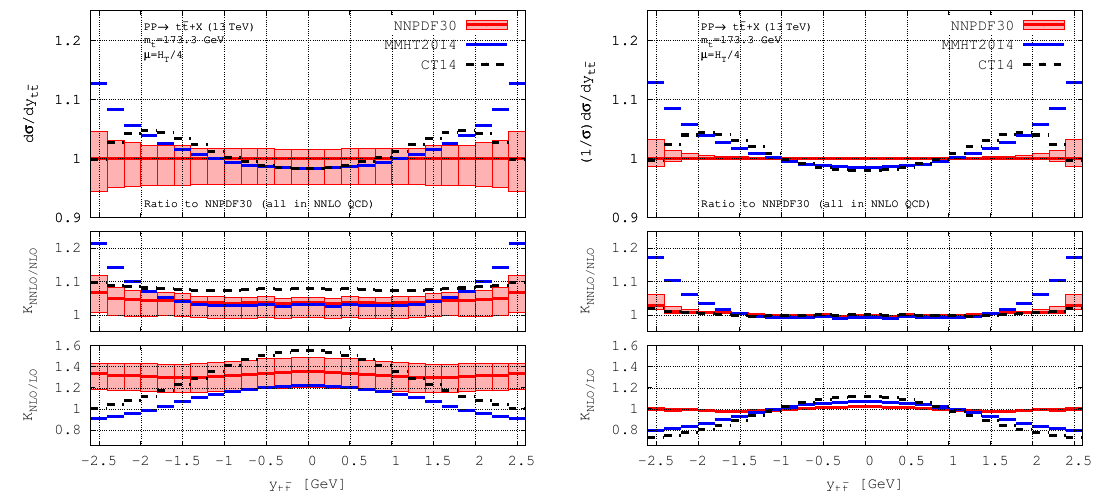
Figure 16 . The unnormalised (left) and normalised (right) y three pdf sets. The distributions are normalised to the NNPDF3.0 central value. Error bands are from scale variation